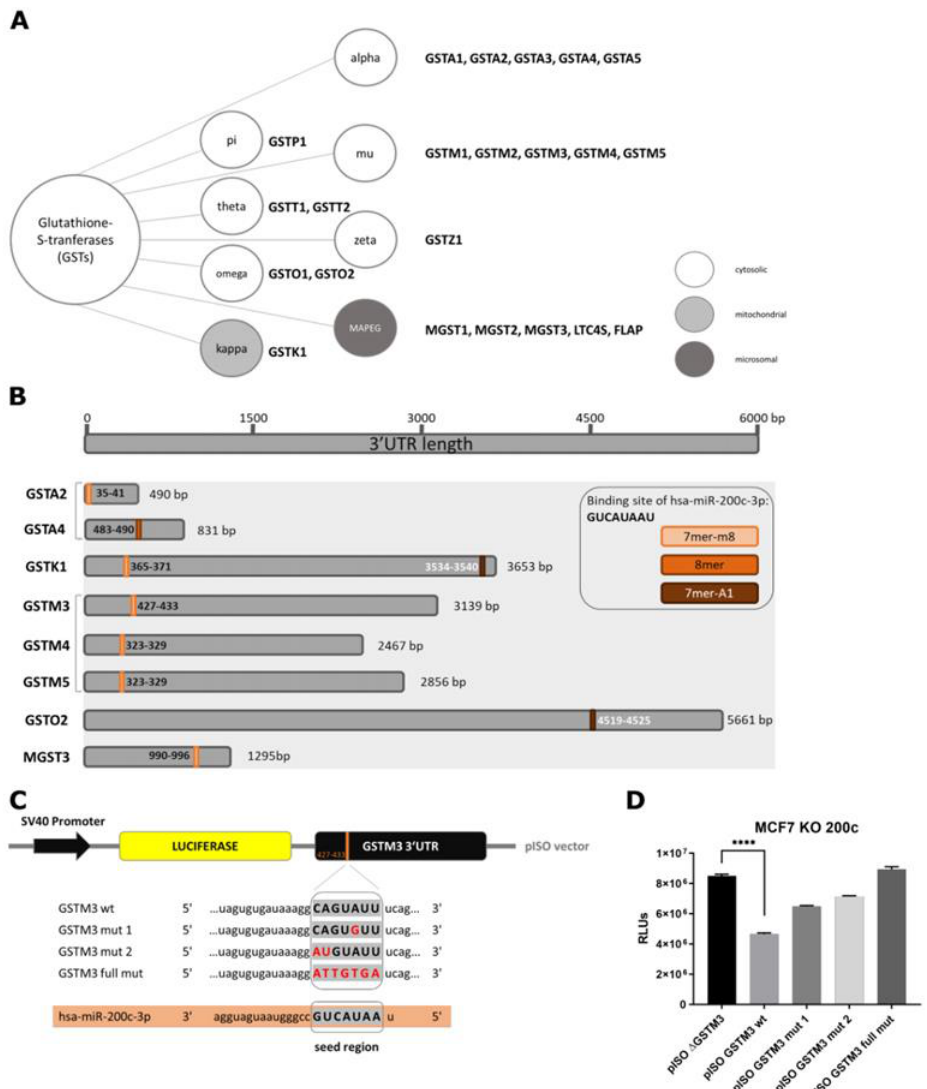
Figure 2. Validation of hsa-miR-200c-3p target site in the 3 ′ UTR of glutathione S-transferases. ( A ) Glutathione S-transferases can be classified into 8 different families. ( B ) The 3′ UTR regions and their length in base pairs (bps) are indicated for the glutathione S-transferases which show a target site for hsa-miR −2 00c. The orange/brown-colored bars display the localization of the hsa-miR −2 00c target site. ( C) Schematic layout of the luciferase reporter plasmid. The unmodified (wt), as well as three different mutations (indicated with red letters) of the GSTM3 3′ UTR, are shown in comparison to the seed region of hsa-miR −2 00c. ( D ) Luciferase assay of the different GSTM3 3′ UTR constructs. Hsa-miR −2 00c and the plasmids were co-transfected into MCF7 KO 200 c cells. One representative diagram out of three is displayed. A two- tailed Student’s t -test for pISO ∆GSTM3 and pISO GSTM3 wt was performed. **** p < 0.0001. Values are displayed as mean with SD.